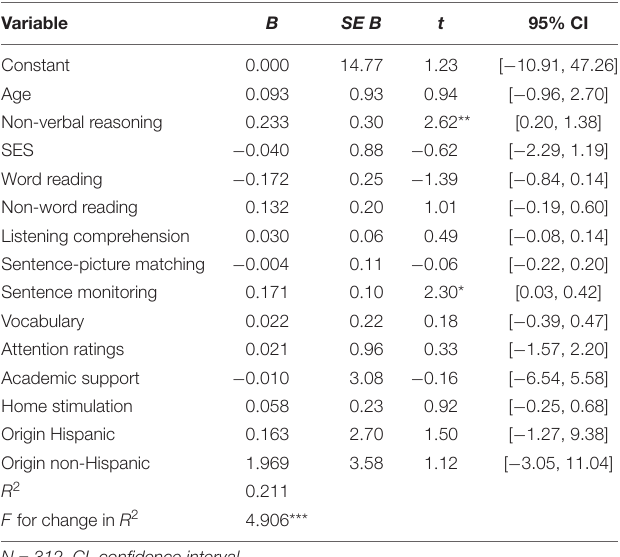
TABLE 4 | Predictors of reading comprehension in the full sample including two dummy variables for immigrant status (HI and NH). Variable